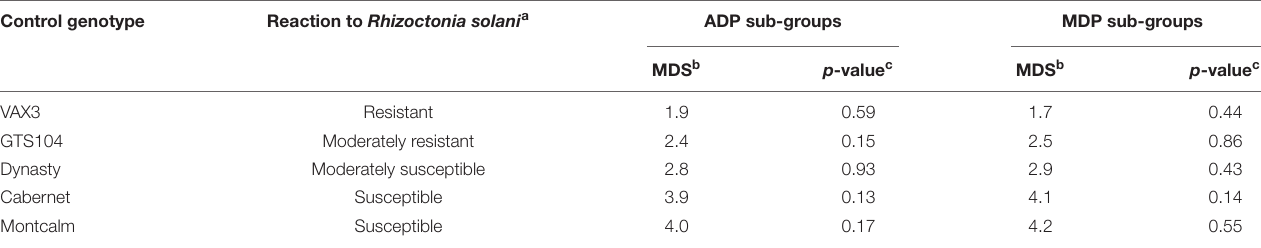
TABLE 1 | Mean disease severity (MDS) of five control genotypes evaluated for root rot reaction to Rhizoctonia solani AG2- 2 across six sub-group evaluations of the Andean Diversity Panel (ADP) and four sub-group evaluations of the Middle American Diversity Panel (MDP). Control genotype